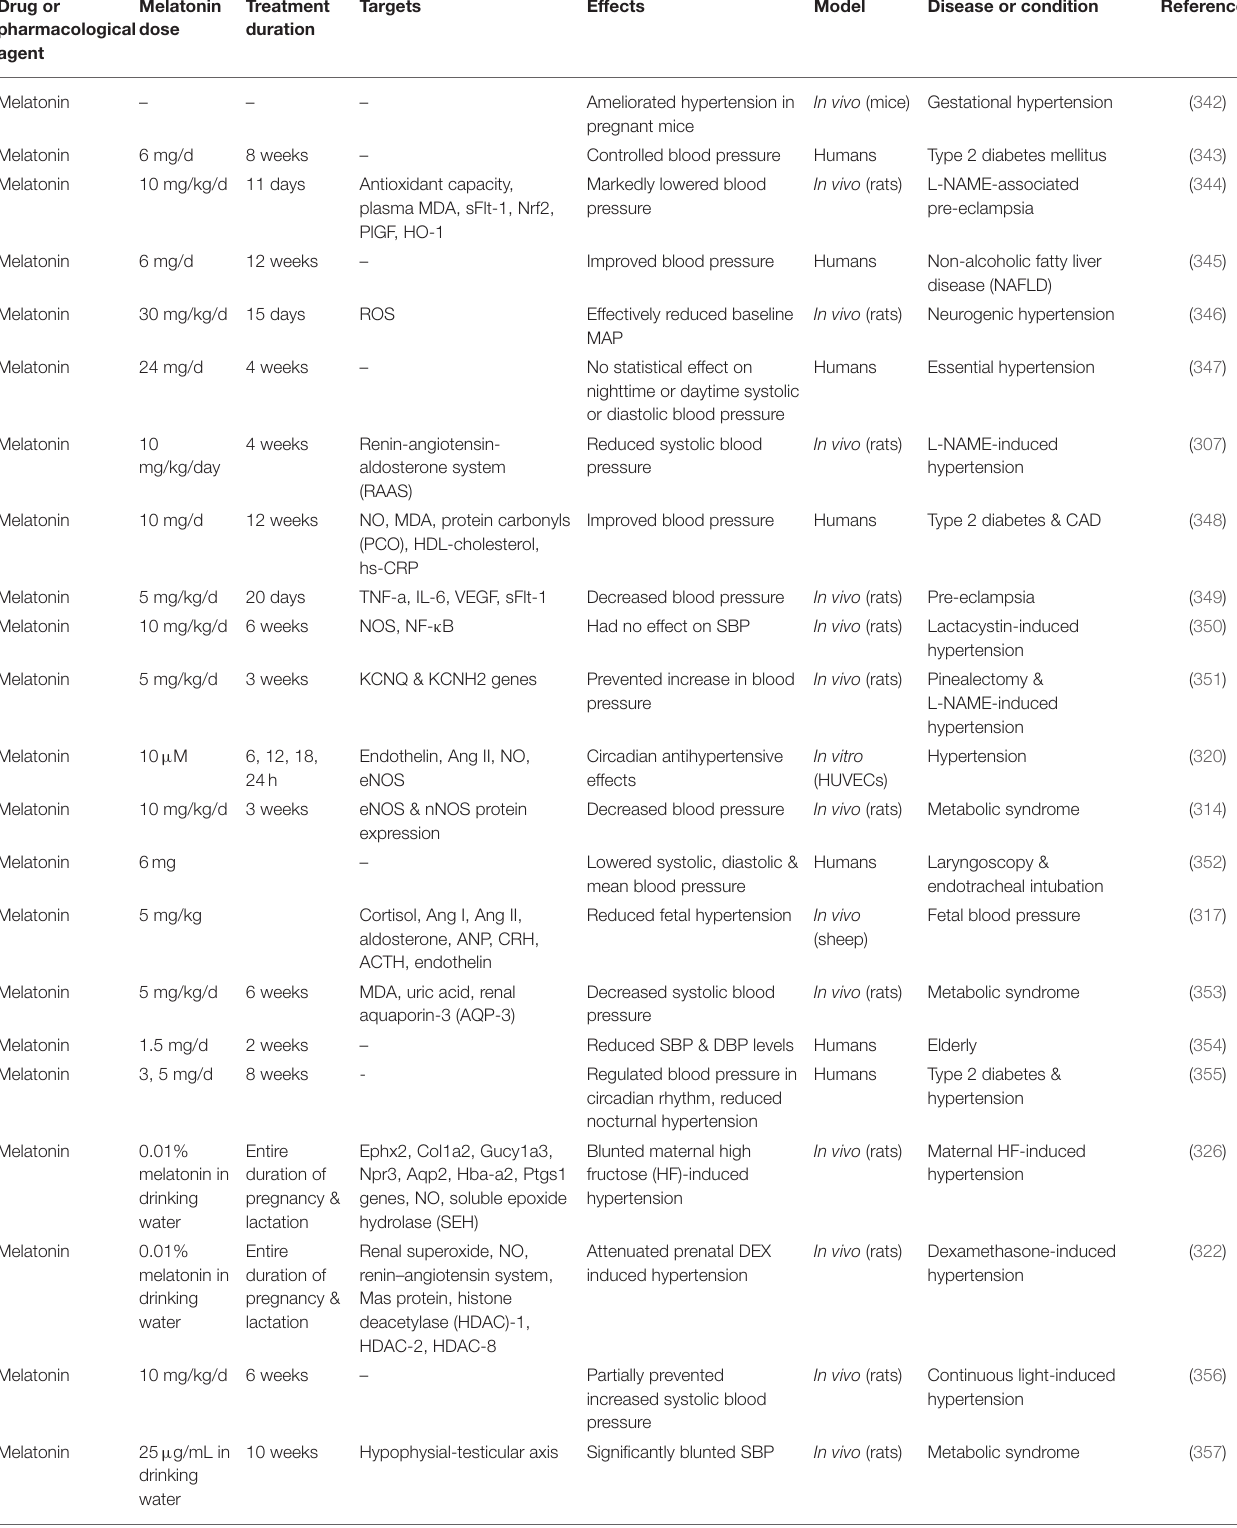
TABLE 4 | Effects of melatonin and blood